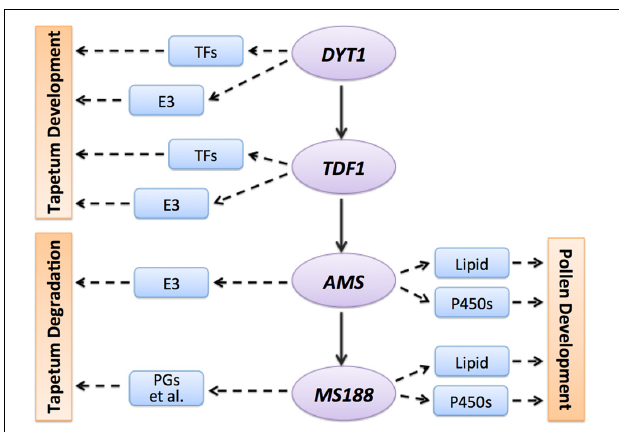
FIGURE 7 | A working model of DYT1-TDF1-AMS-MS188 pathway. Combined of our analysis, here we hypothesis a simple model of how different transcription factor regulate the tapetum and pollen development. TFs, transcription factors; E3, E3 ubiquitin ligases; P450s, cytochrome P450 genes; PGs, polygalacturonases.